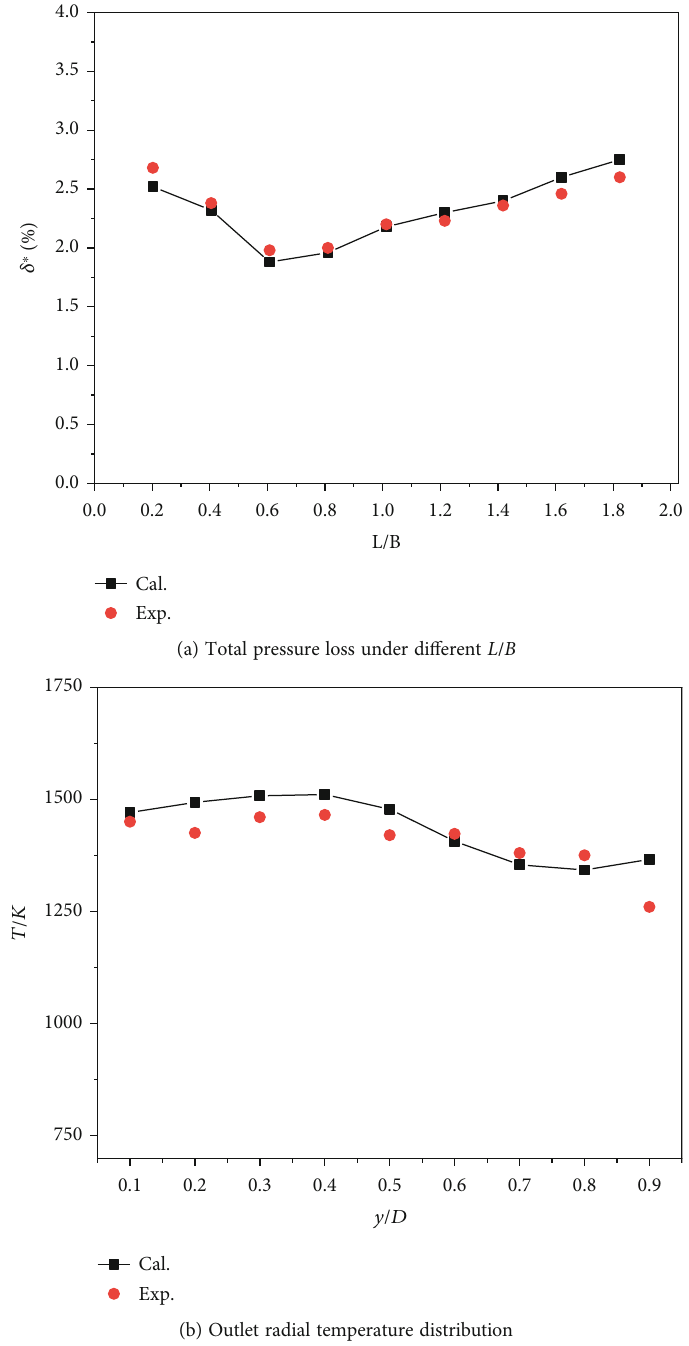
Figure 2: Comparison between simulation and